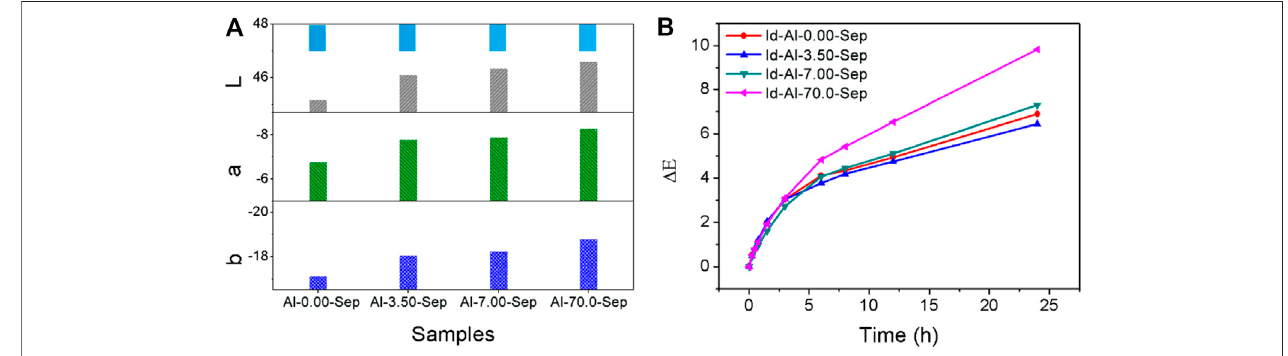
FIGURE 10 | (A) The chromaticity of the composite pigments. (B) The Δ E curves of composite pigments at different irradiation